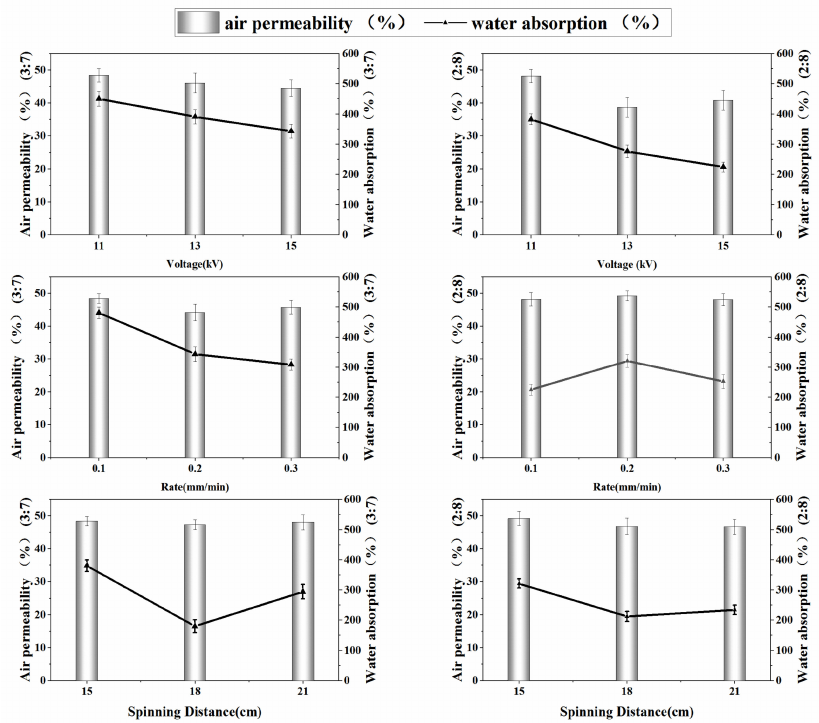
Figure 4. Effect of CS and PVA spinning voltage, advancing speed and spinning distance on water absorption and air